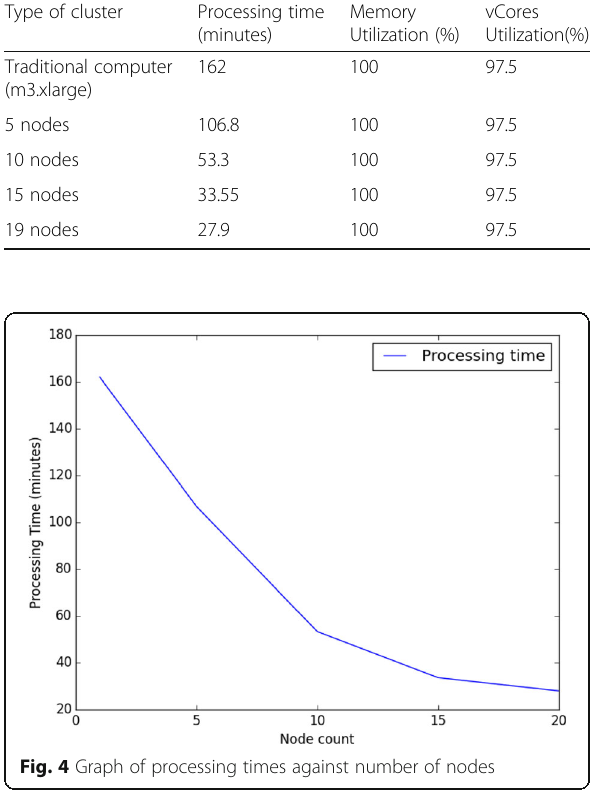
Fig. 4 Graph of processing times against number of